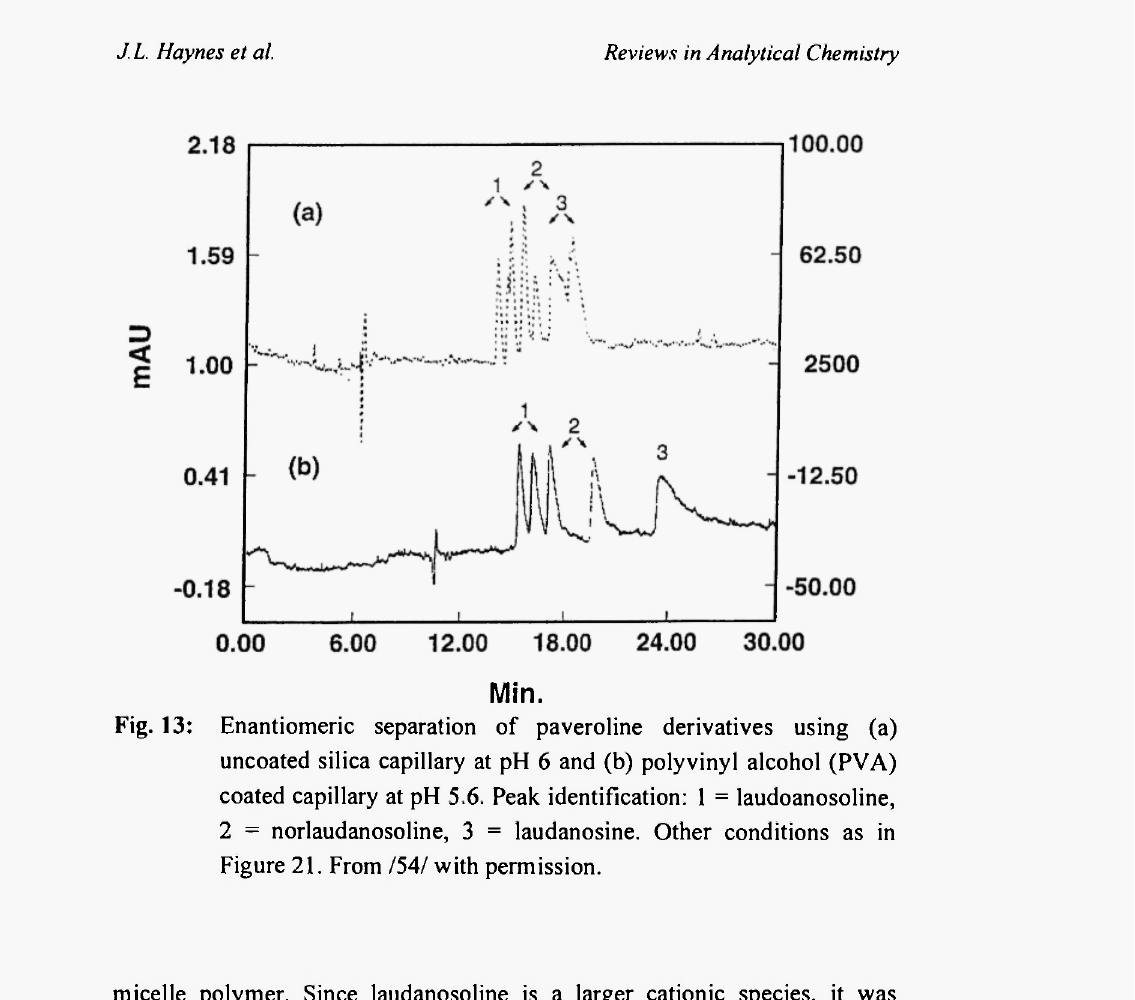
Min. Fig. 13: Enantiomeric separation of paveroline derivatives using (a) uncoated silica capillary at pH 6 and (b) polyvinyl alcohol (PVA) coated capillary at pH 5.6. Peak identification: 1 = laudoanosoline, 2 = norlaudanosoline, 3 = laudanosine. Other conditions as in Figure 21. From 754/ with